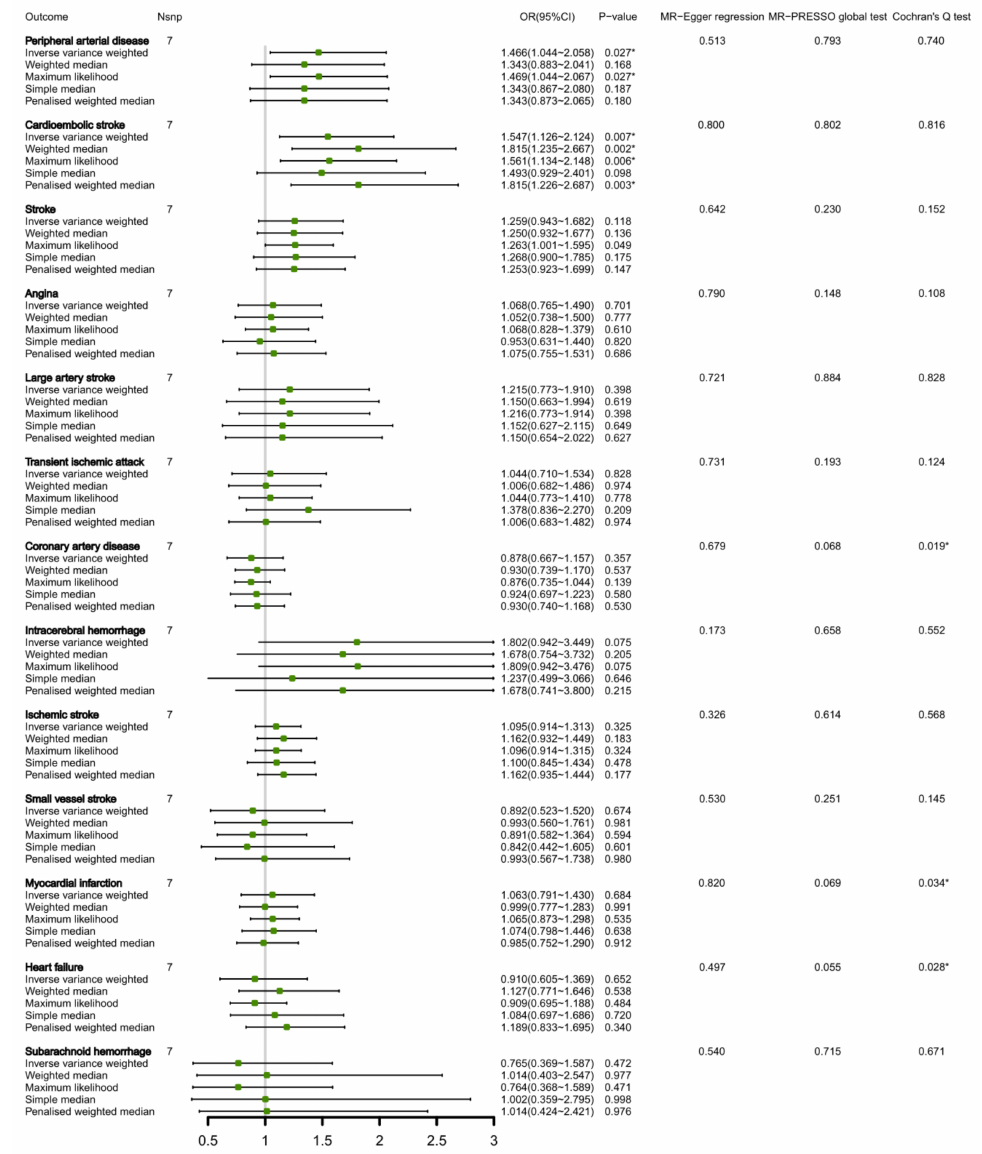
Figure 4. MR estimates of the associations between circulating isoleucine levels and CVDs. * Indicates p < 0.05. Nsnp, number of